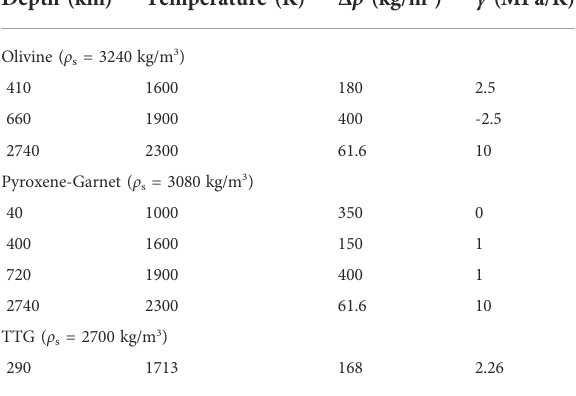
TABLE 2 Phase change parameters for olivine, pyroxene-garnet, and TTGsystemswithsurfacedensityat zeropressure ρ s ,densityjump across a phase transition Δ ρ , and Clapeyron slope γ